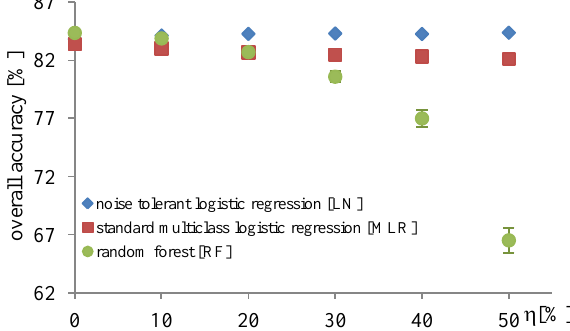
Figure 1. Overall accuracy as a function of the amount of label noise  (NCAR model) for three different classifiers.